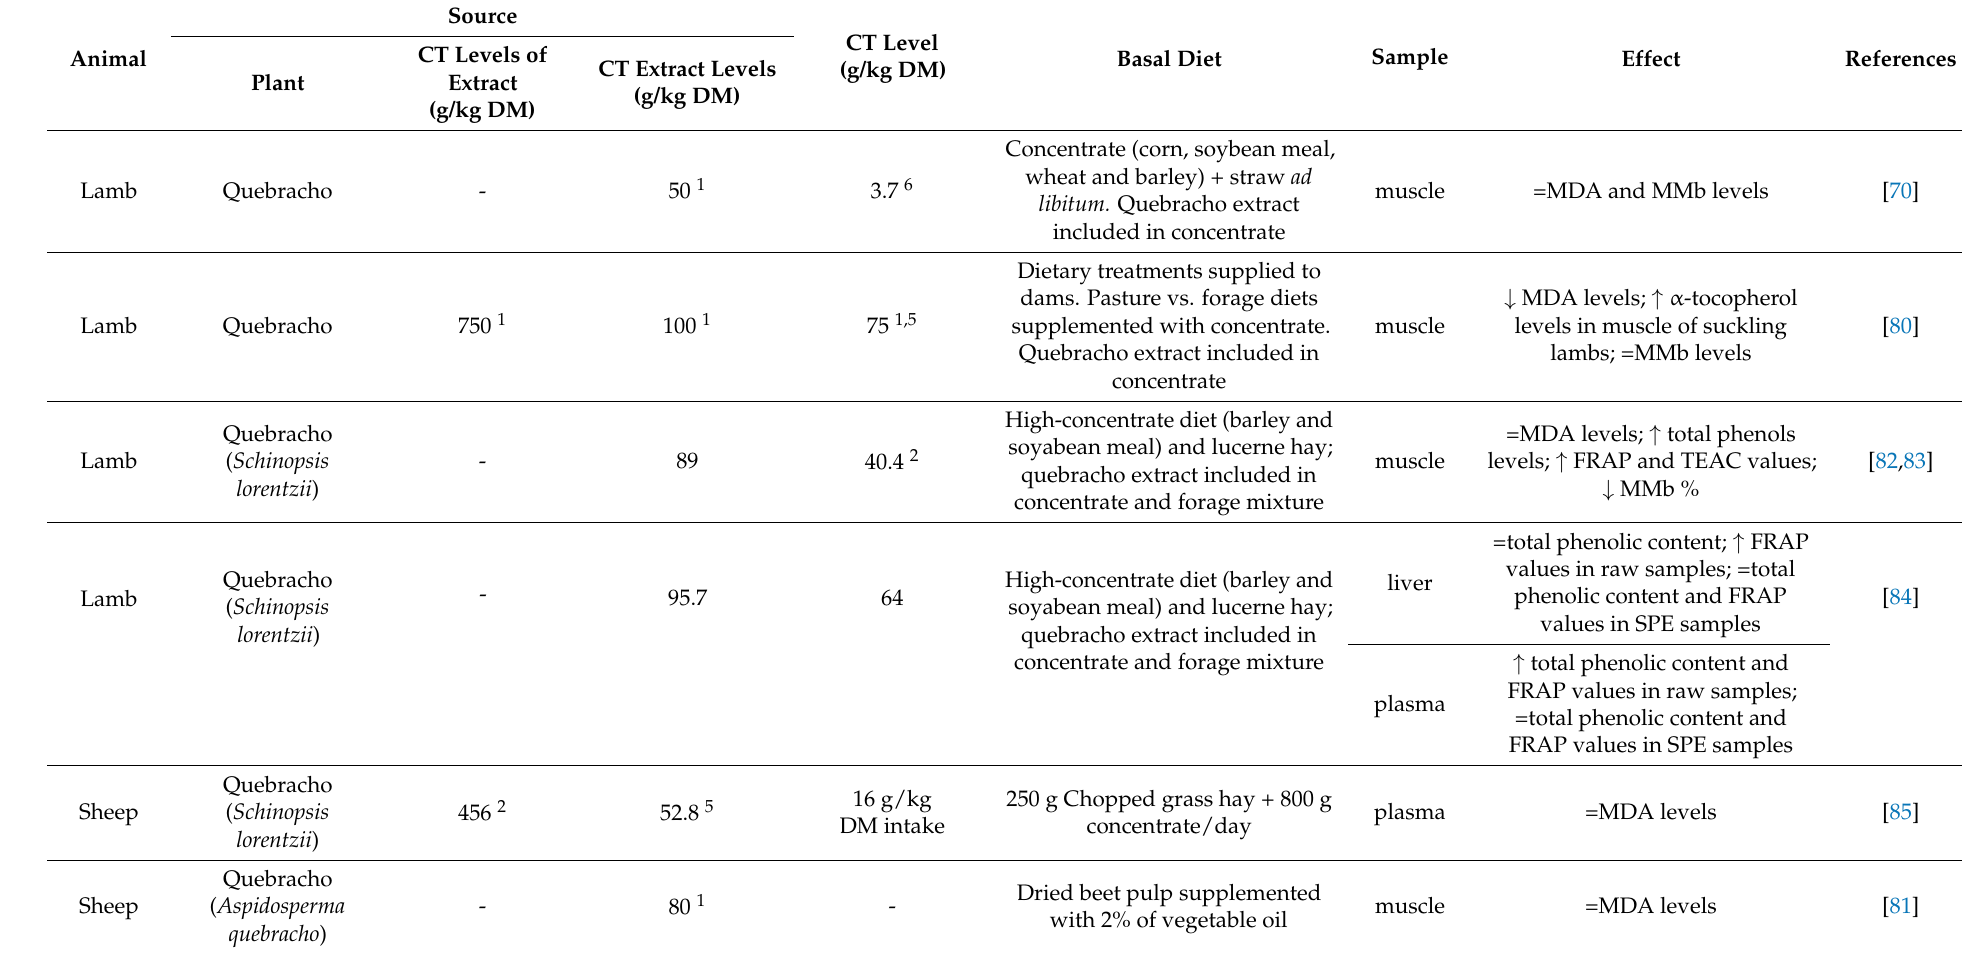
Table 2. Antioxidant effect of utilization of condensed tannin extracts in ruminant